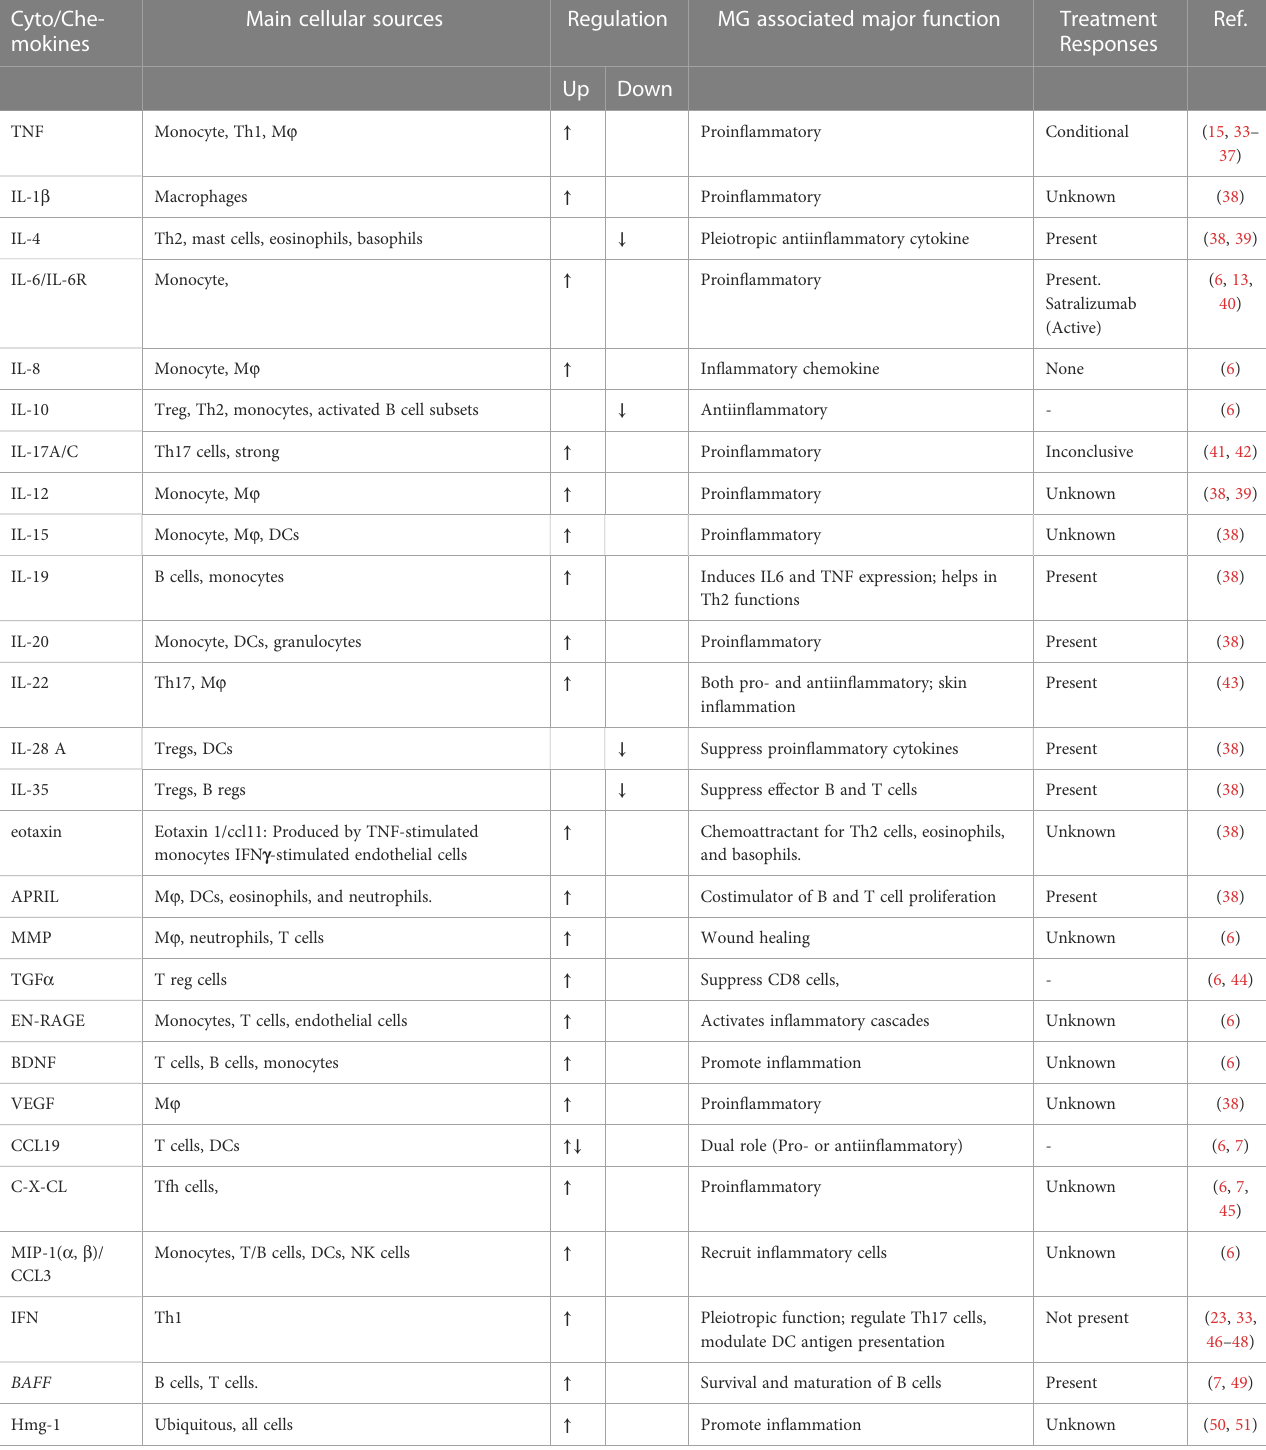
TABLE 1 Cyto/Chemokines: potent contributors of MG pathogenesis. Cyto/Che-